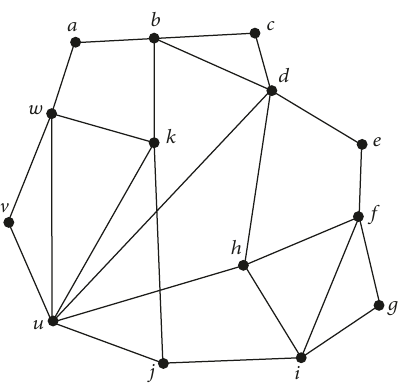
Figure 14: 𝐻 ∗ (𝑎 8 ,𝑏 1 ) .